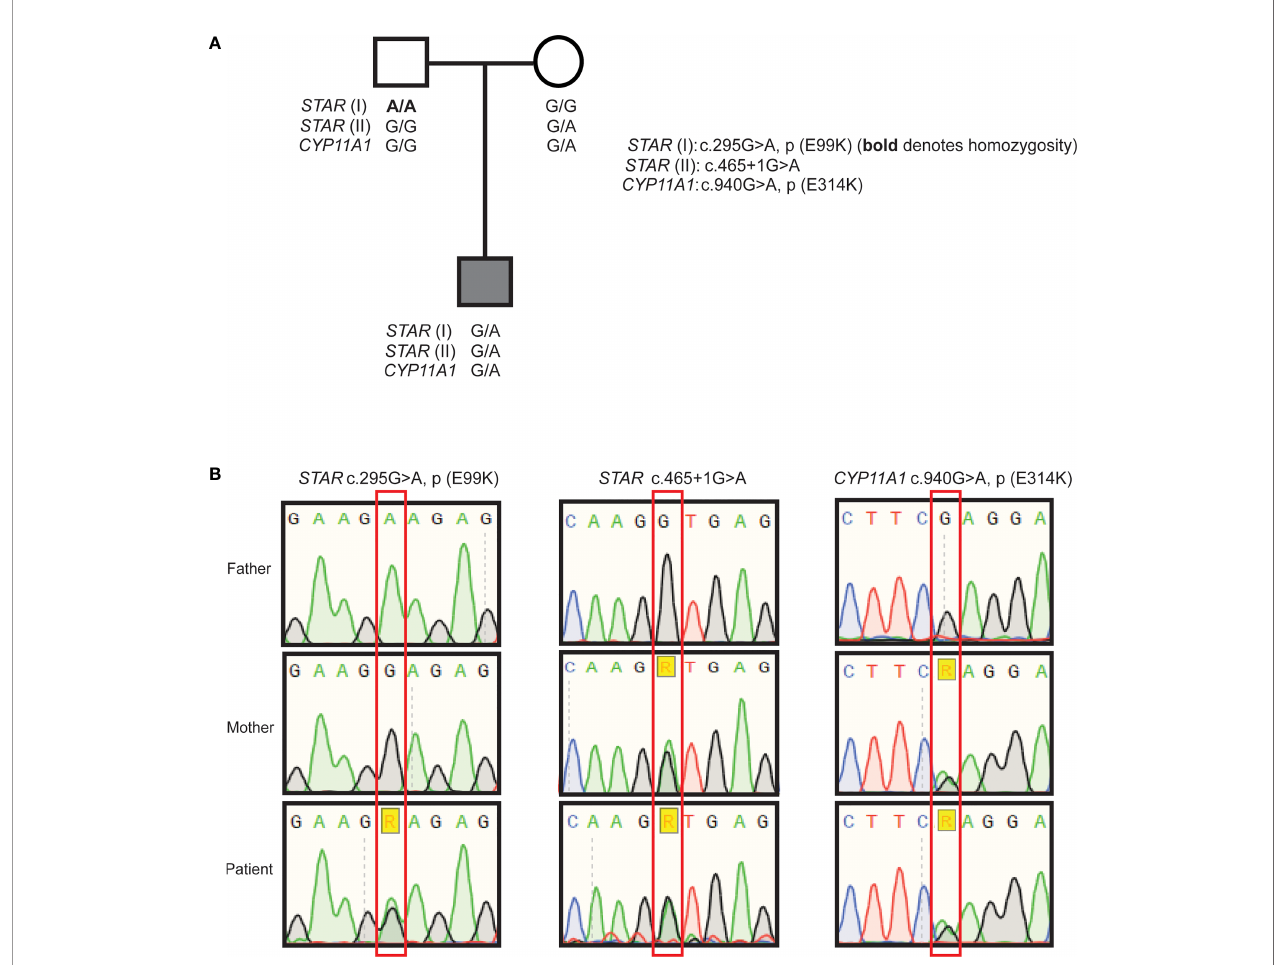
FIGURE 1 | Pedigree of the patient and Sanger sequencing results. Family pedigree indicating inheritance of the variants (A) , partial chromatograms from Sanger sequencing of STAR variants p.(E99K), c.465+1G>A, and CYP11A1 rs6161; c.940G>A (B)